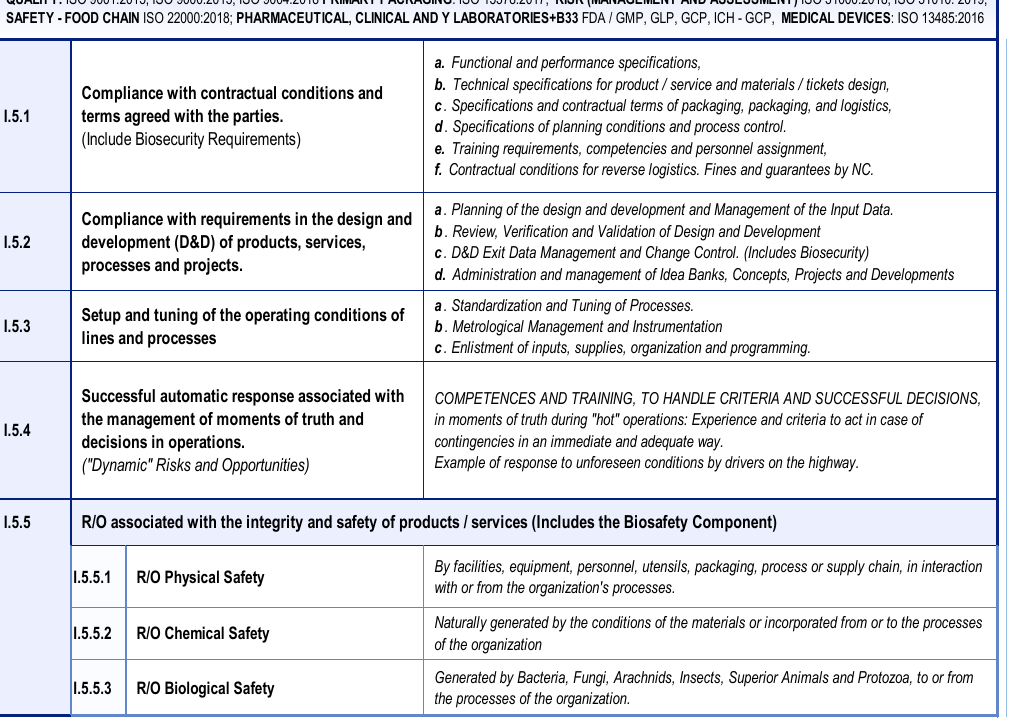
Figure A10. Classification matrix of topics related to internal R/O. Layer II: I.5. [25,48,50,65].